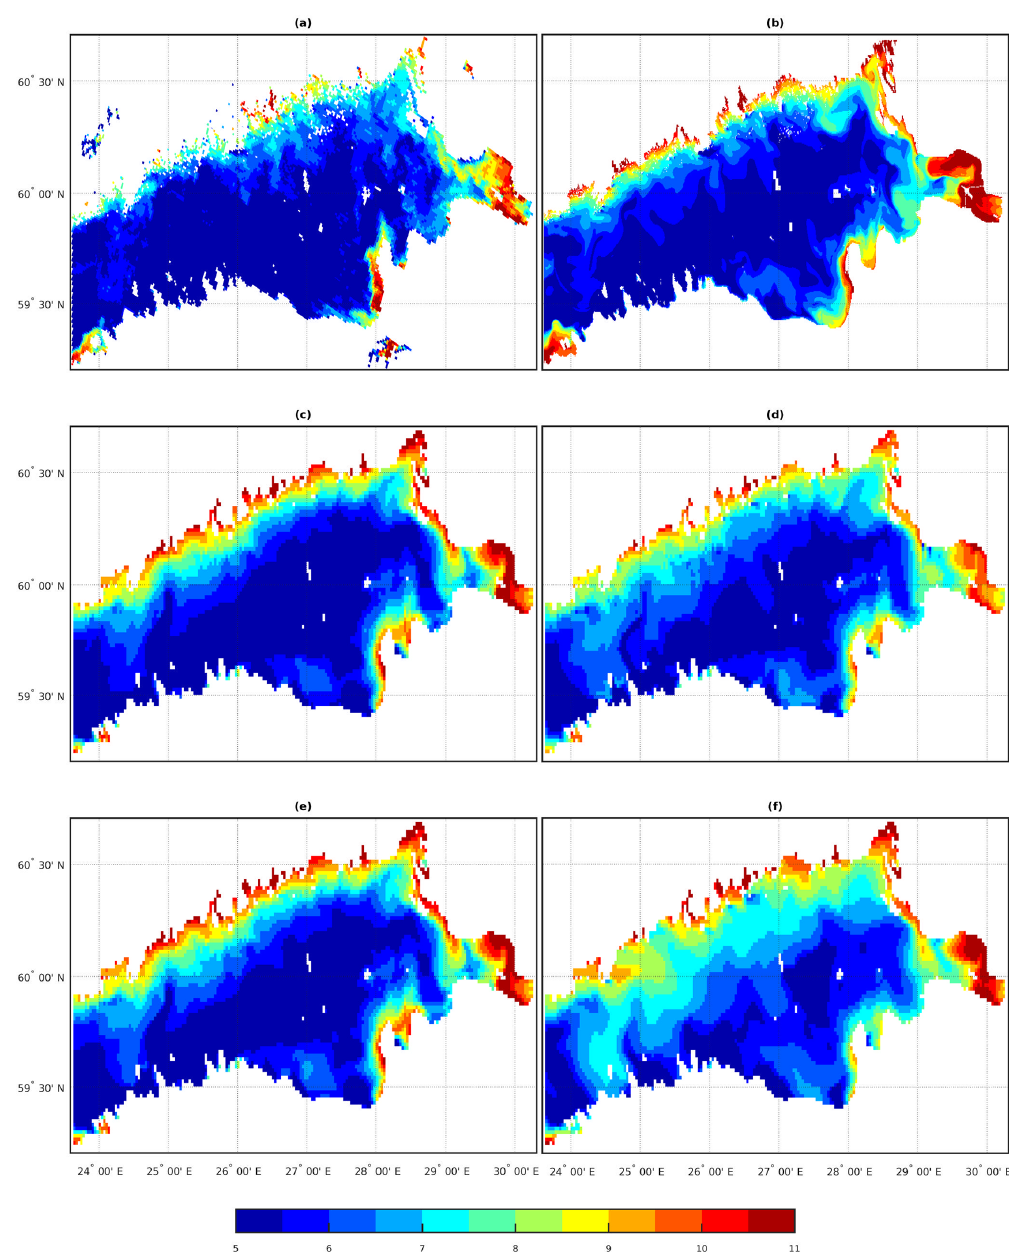
Figure 3. SST on 20 May 2011: (a) MODIS SST; (b) GLS with a Galperin limit 0.53, and horizontal resolution 0.5km; (c) GLS with a Galperin limit 0.53 and horizontal resolution 2km; (d) GLS with a Galperin limit 0.26 and horizontal resolution 2km; (e) TKE with convective adjustment and horizontal resolution 2km; (f) GLS with a Galperin limit 0.07 and horizontal resolution